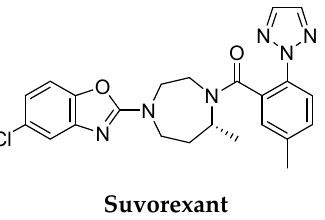
Figure 4. The structure of suvorexant—FDA-approved drug for treating insomnia in patients with mild-to-moderate AD dementia.